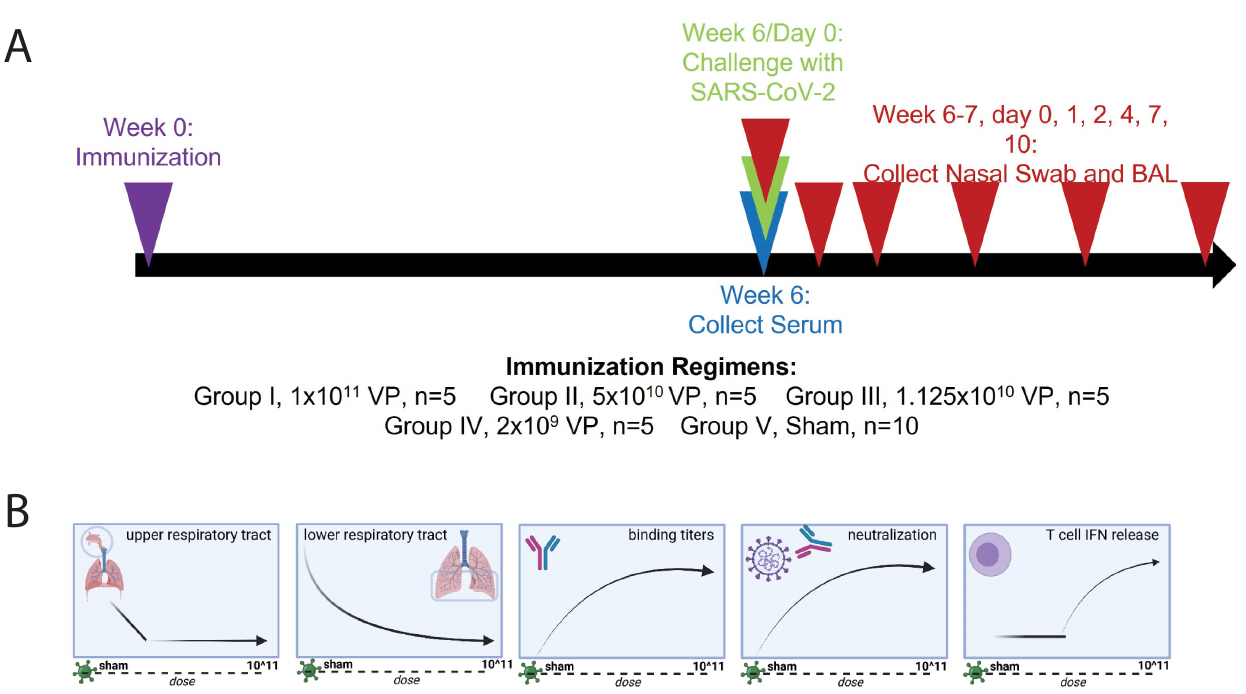
Fig 1. AD.COV2.S dose-down immunization scheme and graphical depiction of the immune response. (A) Rhesus macaques were immunized with 5 different doses of Ad26.COV2.S, profiled for their immune response, and challenged with SARS-CoV-2. The timeline shows the timing of immunization (week 0), serum collection (week 2, 4, and 6), SARS-CoV-2 challenge (day 43), and viral titer sampling of the cohort (day 0, 1, 2, 4, 7, and 10 postinfection). The legend states the dose of Ad26.COV2.S given to each group of NHP. (B) From left to right, summary of the observed trends of viral sgRNA in the upper respiratory tract, sgRNA in the lower lower respiratory tract, binding antibody titer, neutralizing antibody titer, and T-cell IFN γ secretion as they relate to dose. Fig 1B was created with BioRender.com. BAL, bronchoalveolar lavage; IFN γ , interferon gamma; NHP, nonhuman primate; SARS-CoV-2, Severe Acute Respiratory Syndrome Coronavirus 2; sgRNA, subgenomic RNA; VP, viral